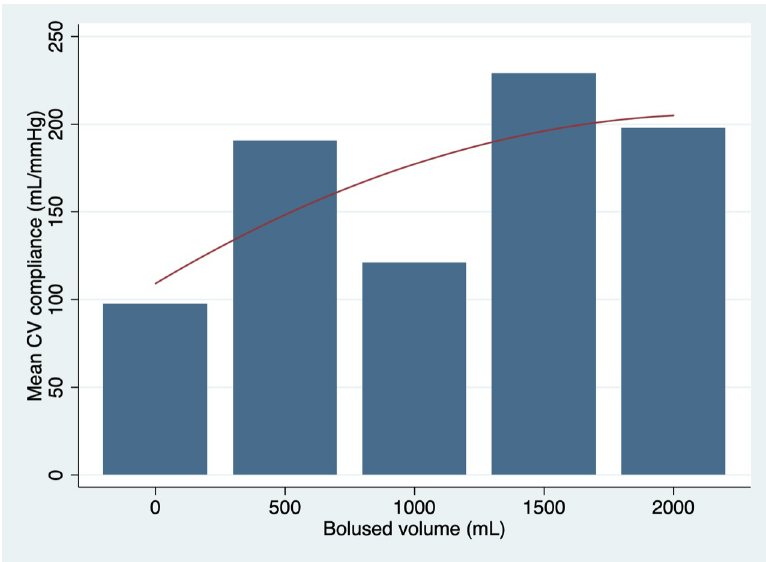
Fig 1. Graphic presentation of the mean global cardiovascular (CV) compliance plotted against bolus volume with a quadratic line of best fit with all sheep analysed.